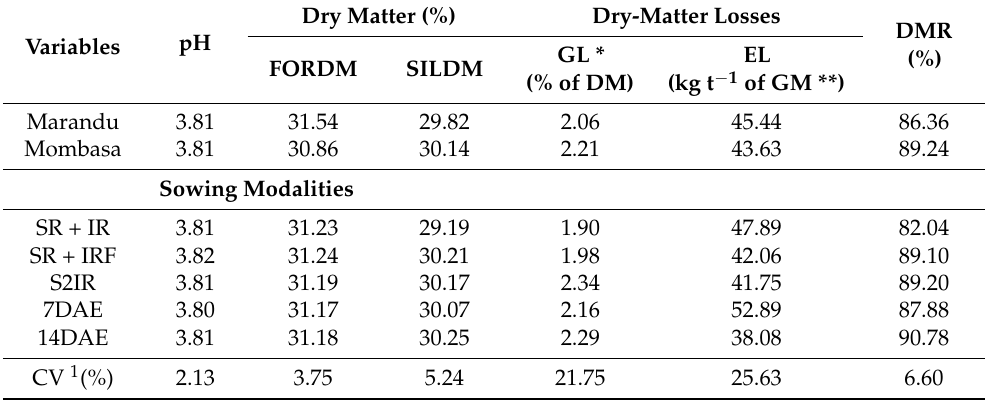
1 Coefficient of variation (%). * Data transformed by √ x . ** GM: green mass. SR + IR: simultaneous row sowing and inter-row corn sowing; SR + IRF: simultaneous row sowing and inter-row corn sowing (with fertilizer); S2IR: simultaneous sowing with double grass row in the corn inter-row; 7DAE: delayed sowing inter-row at 7 days after corn emergence; and 14DAE: delayed sowing inter-row at 14 days after corn emergence. There was a significant effect of the interaction between grasses and sowing modal- ities on the NH 3 -N content (Table 5). The NH 3 -N contents were higher in corn silages intercropped with Marandu grass. Among the sowing modalities, the highest NH 3 -N